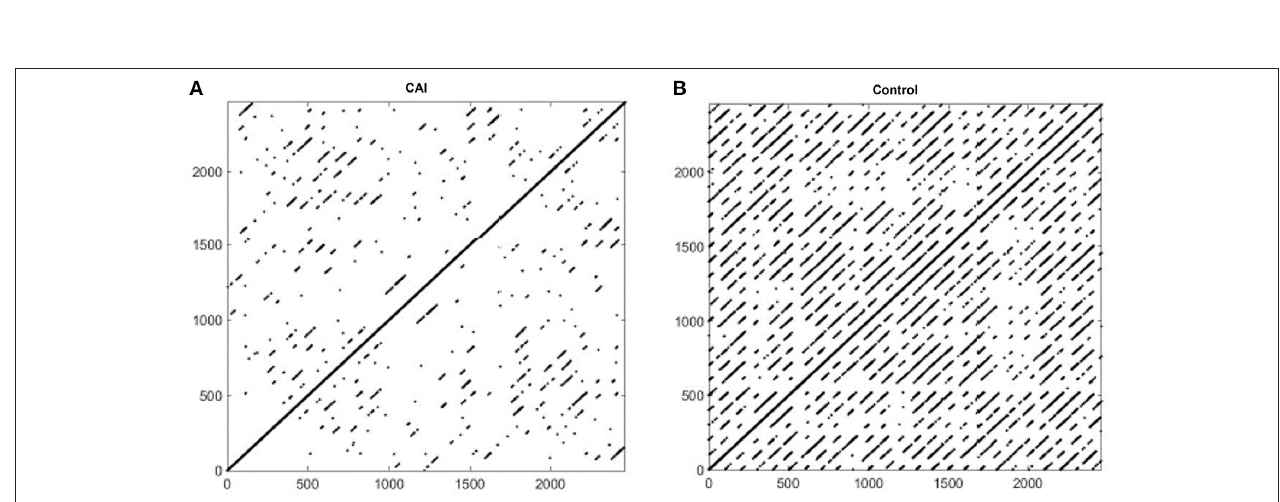
FIGURE 2 | Recurrence plots of an example participant with CAI (A) and healthy control (B) in the frontal plane. CAI, chronic ankle